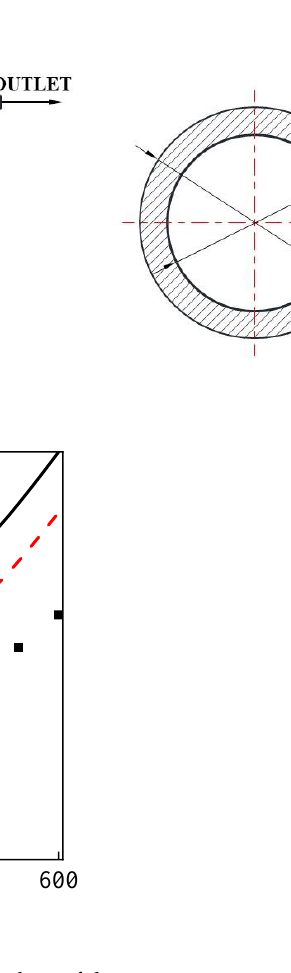
Figure 6. Comparison of simulation and experimental values of the average temperature of the inner cross-section of the spiral tube. cross-section of the spiral